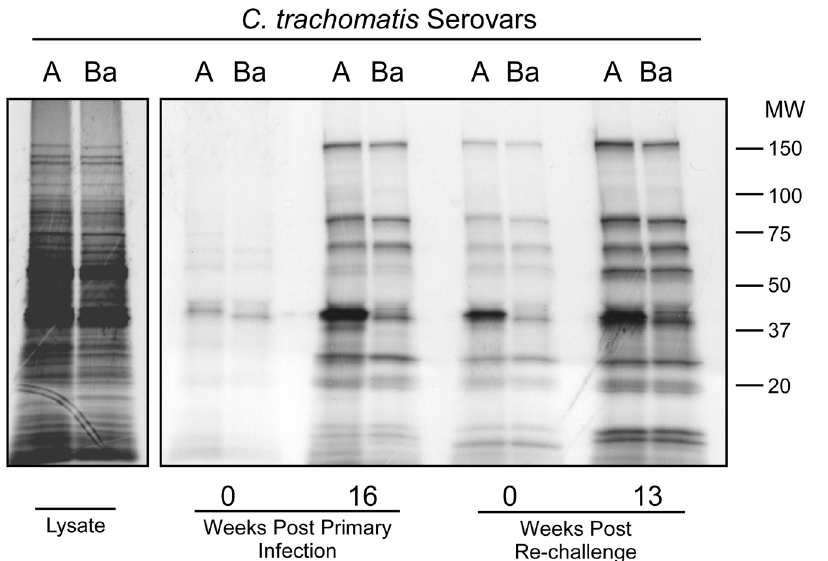
Figure 2. The majority of chlamydial antigens recognized during primary infection and re-challenge are shared between trachoma serovars. RIP was performed using lysates made from C. trachomatis serovars A2497 and Ba. Serum from monkey RML134 was used in the experiment and four representative time points throughout the course of infection and re-challenge were analyzed. Antibody to MOMP was serovar- specific, reacting most intensely with the infecting A2497strain. Conversely, antibody reactivity against the other immunogenic proteins was cross- reactive between trachoma serovars demonstrating that these antigens are conserved.